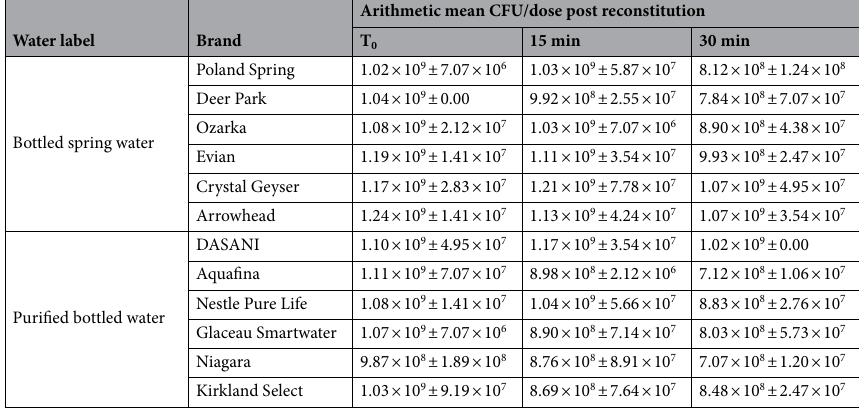
Table 5. PXVX0200 viability when reconstituted in bottled spring and purified bottled waters (2016).